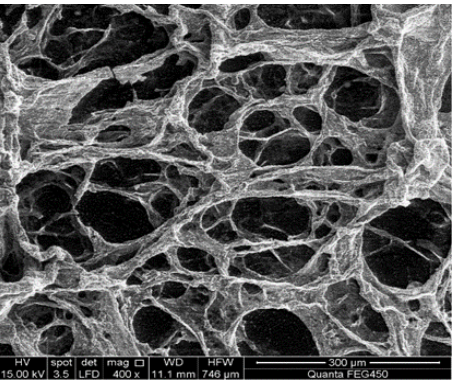
Figure 5. SEM image of polymer gel.